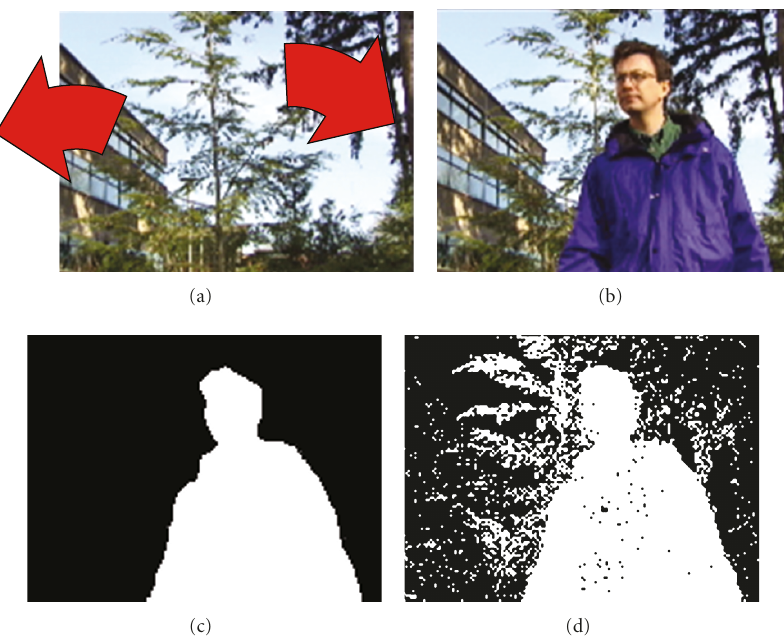
Figure 2: A typical example of ill-posed BG subtraction issue: the oscillating background. (a) A frame representing the background scene, where a tree is oscillating, as highlighted by the arrows. (b) A moving object passes in front of the scene. (c) The ground truth, highlighting only the real foreground object. (d) The result of the background subtraction employing a standard method: the moving branches are detected as